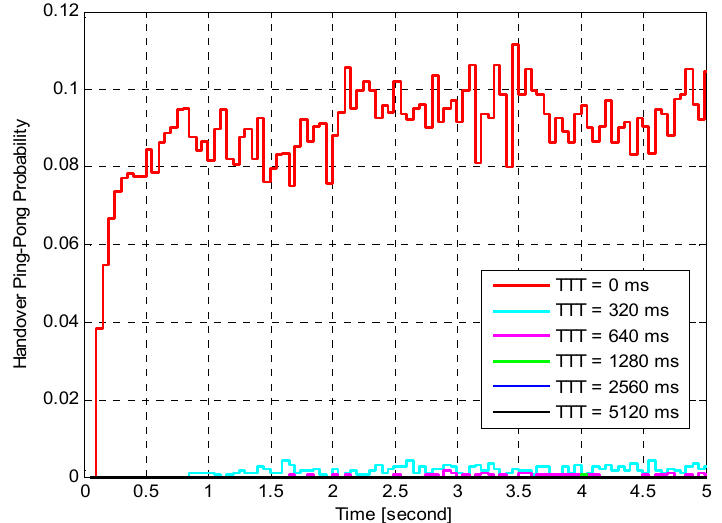
Figure 8. Handover ping-pong probability versus time.